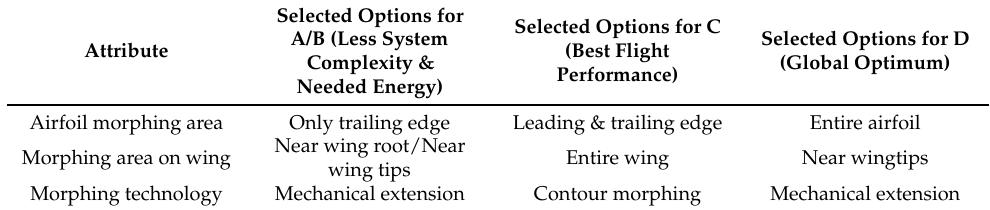
Table 4. Selected technologies for the local maxima configurations.